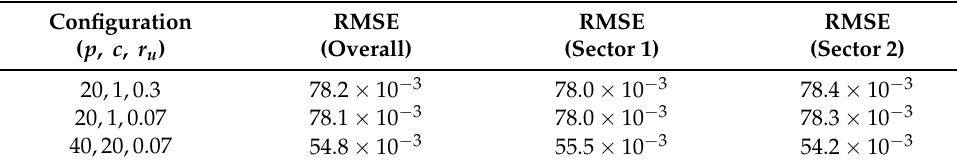
Table 3. RMSE for Test